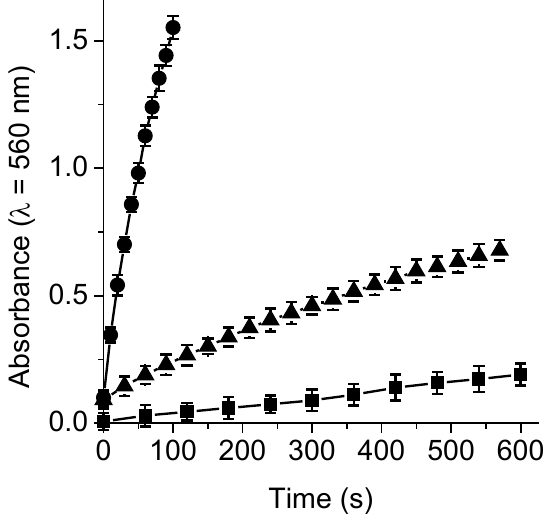
Figure 4. Time course of O 2 •− formation sensed by the NBT approach following the increase in the absorption at 560 nm for NBT + NADH + ZnTEP ( • ), NBT + NADH + PZnTEP ( (cid:78) ) and NBT + NADH ( (cid:4) ) in DMF/water (5%), [NBT] = 0.2 mM and [NADH] = 0.5 mM, λ irr = 455–800 nm.